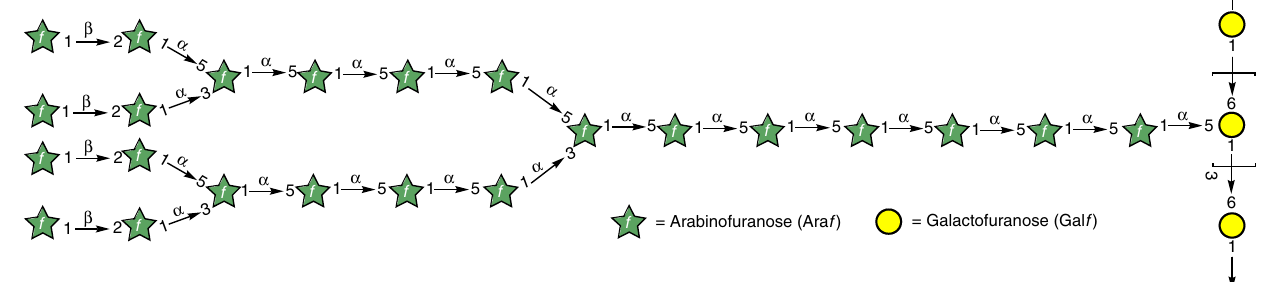
Figure 1 | Arabinogalactan motif of Mycobacterium tuberculosis cell wall. Arabinan is attached at the C-5 position of the galactan. Both arabinose and galactose are in the furanosyl form. Gal f (1 - 6)Gal f linkages and Ara f (1 - 3 or 5)Ara f linkages are all in the 1,2- trans manner, whereas Ara f (1 - 2)Ara f linkages are 1 ,2-cis